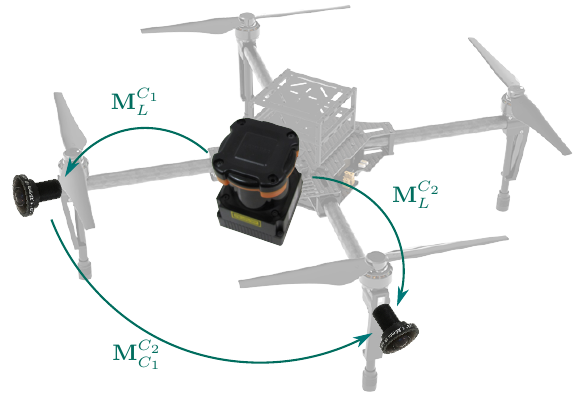
Figure 1: Sketch of an UAS with minimal configuration of sensors utilized by our calibration approach. The purpose of the calibration is to estimate the transformation matrices M .